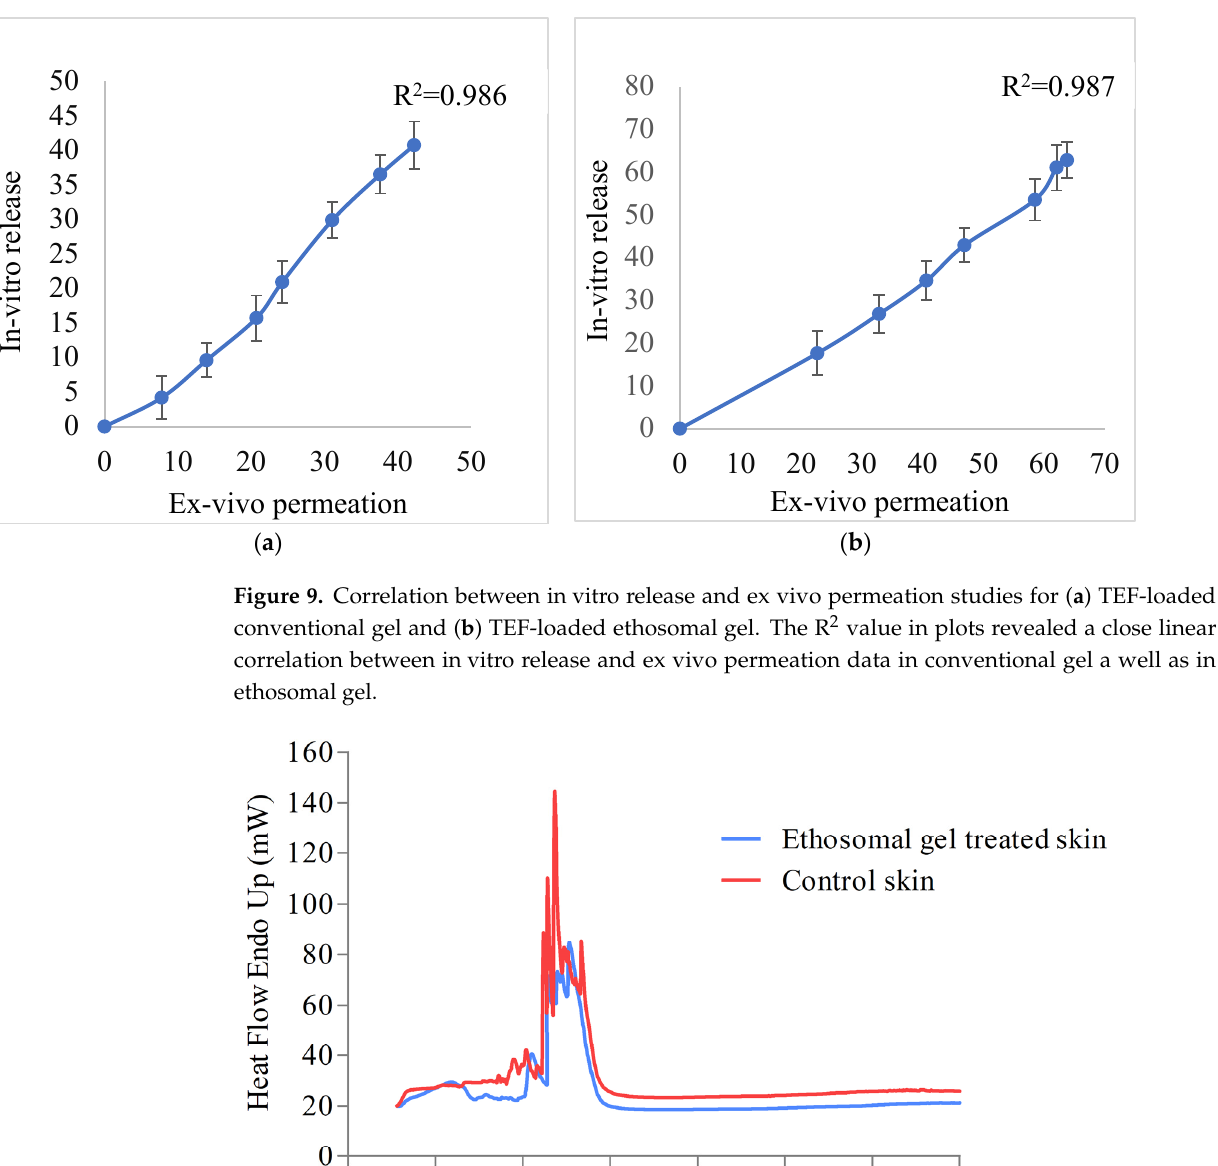
Figure 9. Correlation between in vitro release and ex vivo permeation studies for ( a ) TEF-loaded conven- tional gel and ( b ) TEF-loaded ethosomal gel. The R 2 value in plots revealed a close linear correlation be- tween in vitro release and ex vivo permeation data in conventional gel a well as in ethosomal gel.